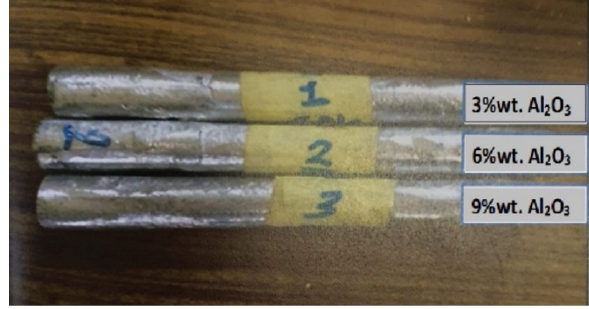
Figure 1: Nano composite samples after manufacturing